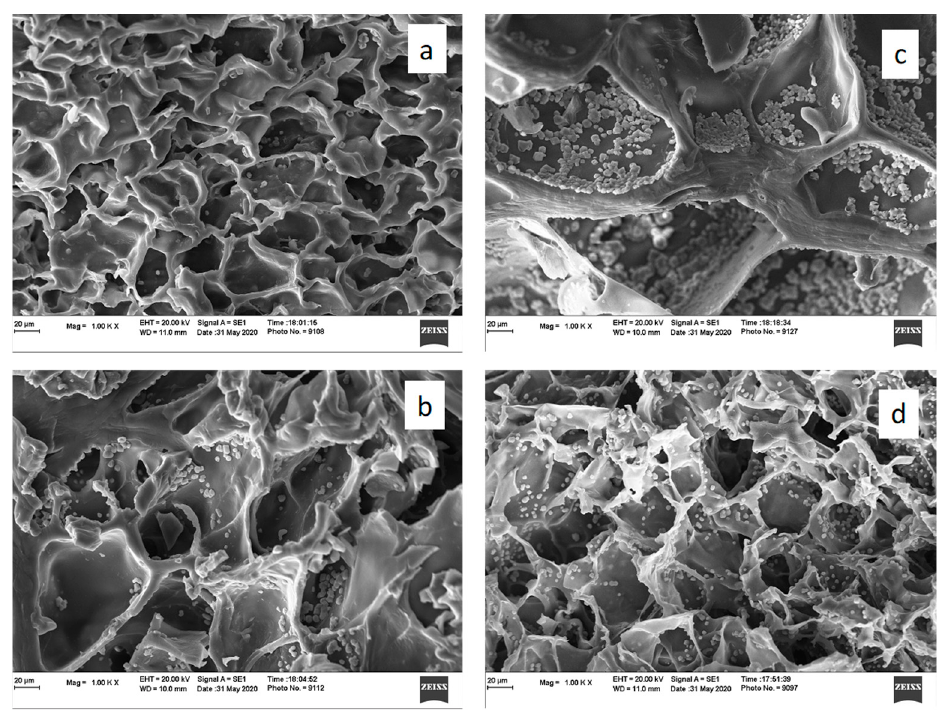
Figure 4. Degradation rate profile for different varieties of DN hydrogels with lysozyme.